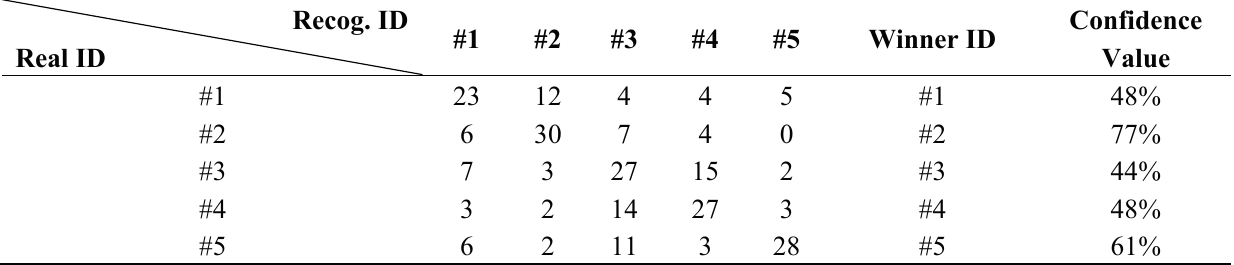
Table 7. Vote matrix of the proposed human identification based on a multimodal